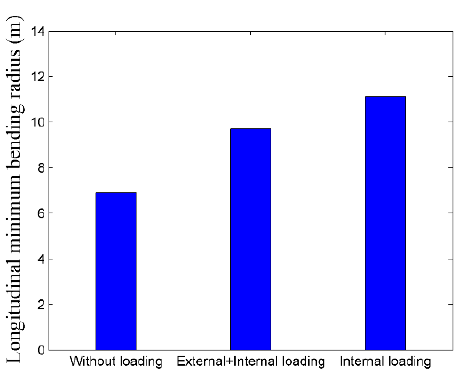
Figure 12. Minimum longitudinal bending radius (MLBR) comparison regarding loaded and unloaded models of proposed enclosure scheme based FGIL.